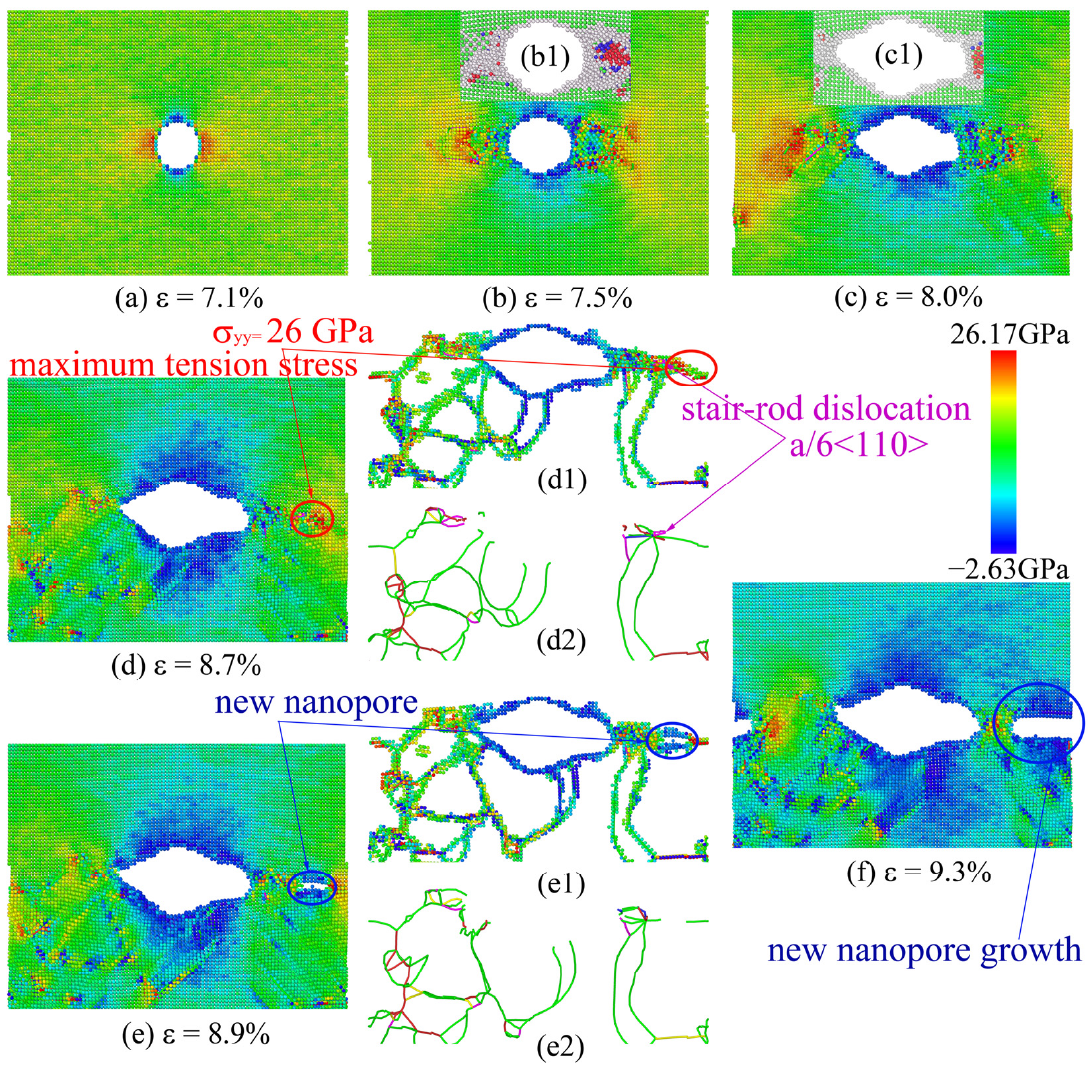
Figure 7. The contour plots of the atomic tensile field and crack growth states at different tensile strains (EAM potential).